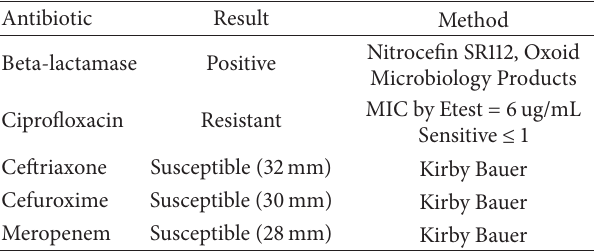
Table 1: Haemophilus parainfluenzae susceptibility results. Antibiotic